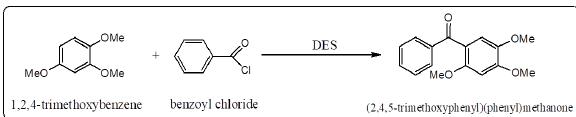
Figure 16: DES catalyzed Friedel-Crafts acylation of 1,2,4-trimethoxybenzene and benzoyl chloride.